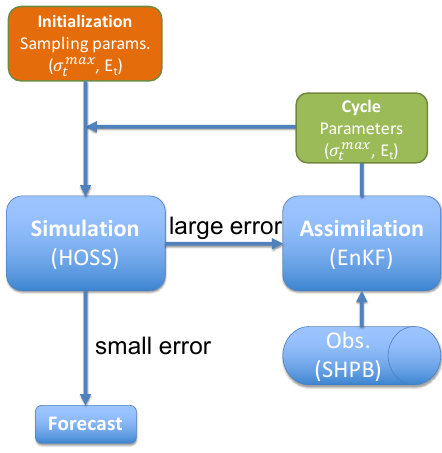
Figure 3. Data assimilation cycle for HOSS with EnKF for estimating key model parameters. The de- fault parameters are passed to HOSS. If the error between the model output against observations is large, then the assimilation is performed, which provides new parameter values. The assimilation cycle is performed until the error between the model output and observations is small enough (a certain